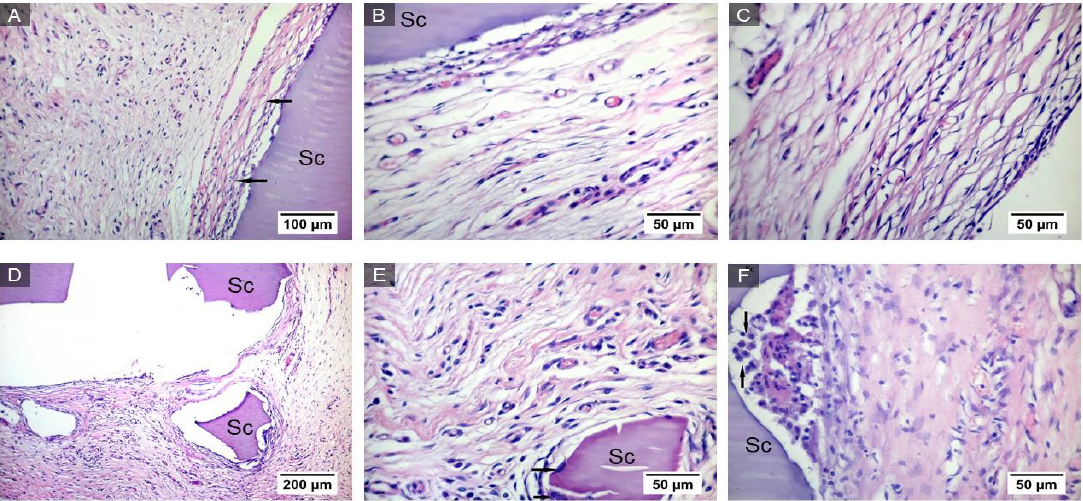
Figure 7. Implant from synthesized GelMA in the subcutaneous tissue of rats after 33 days (marked with Sc), surrounded by a connective tissue capsule. Connective tissue capsule around the implant (shown by arrows). Staining with hematoxylin and eosin. Magnification of the image— × 20 ( A ). Collagen fibers in the connective tissue capsule. Staining with hematoxylin and eosin. Magnification of the image— × 40 ( B ). Connective tissue of the capsule around the implant. Staining with hematoxylin and eosin. Magnification of the image— × 40 ( C ). Fragments of the implant. Staining with hematoxylin and eosin. Magnification of the image— × 10 ( D ). Magnification of the image— × 40. Arrows show multinucleated macrophages ( E ). Circumcellular infiltrate (marked with arrows) in the border zone between the capsule and the implant (marked with Sc) after 33 days. Hematoxylin and eosin staining. Magnification of the image— × 40 ( F